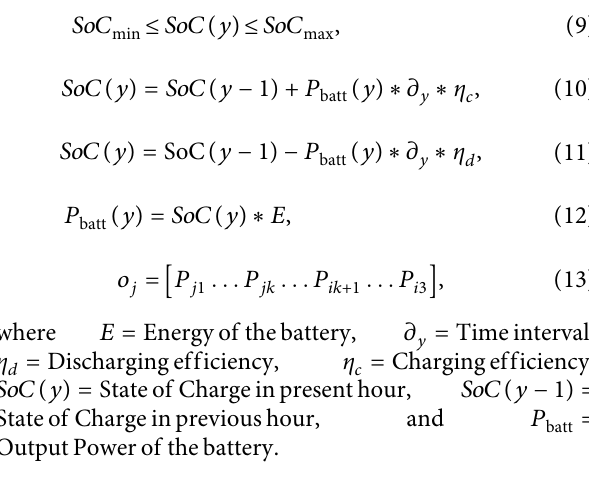
Figure 1: EV power vs time plot.